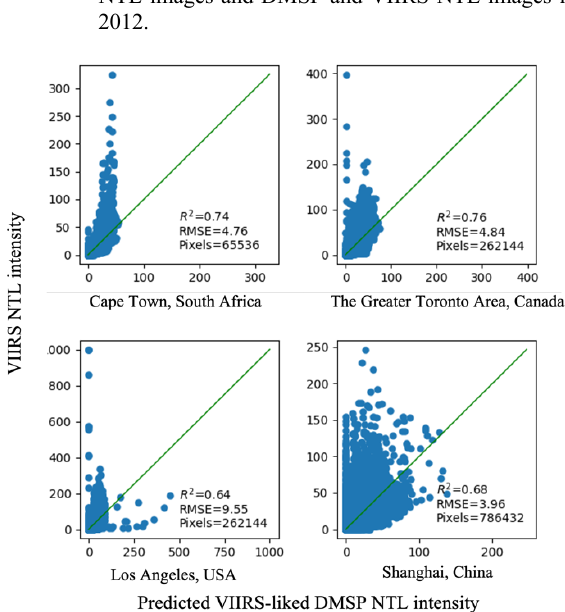
Figure 4. Comparison of pixel values between predicted VIIRS- liked NTL and VIIRS NTL images in four metropolitan areas. The solid line represents the 1:1